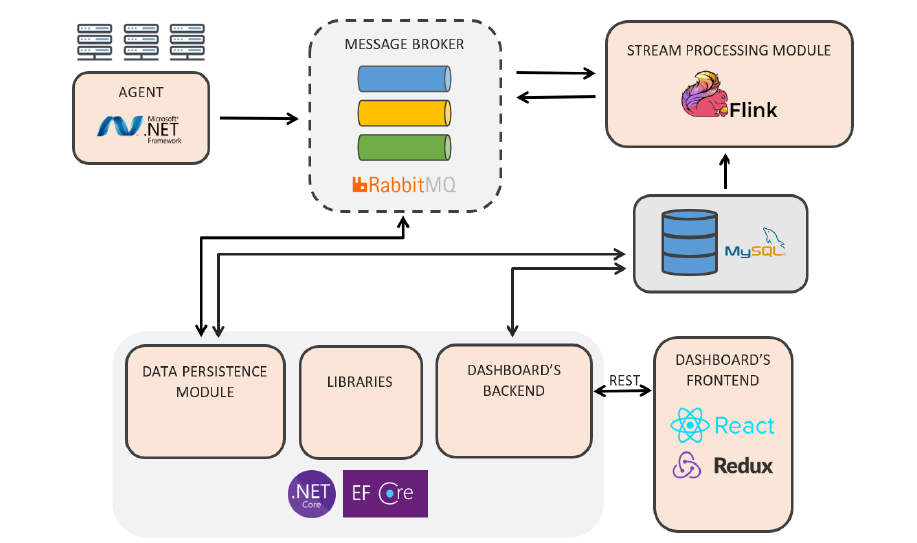
Figure 1. The Chopin management system